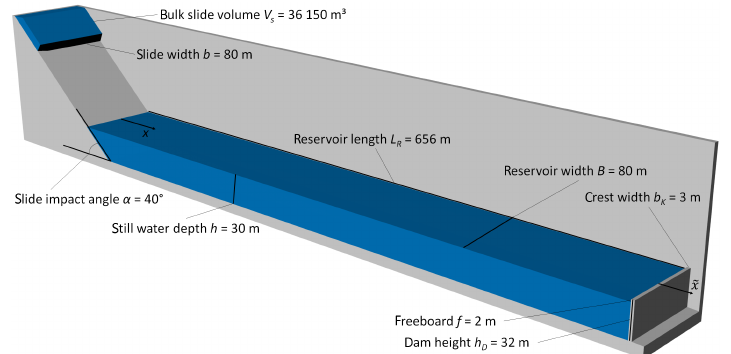
Figure 2. Reference geometry including the initial condition at time = 0s.